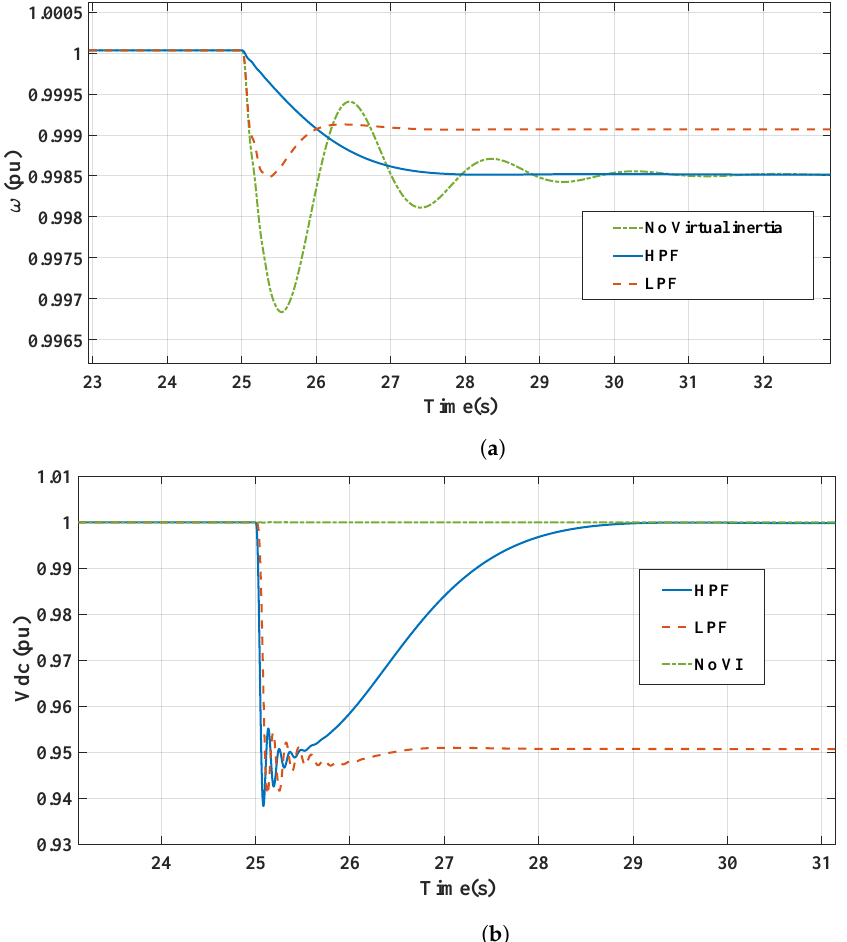
Figure 12. Comparison between LPF- and HPF-based controllers for virtual inertia loop: ( a ) Frequency response, ( b ) DC link voltage